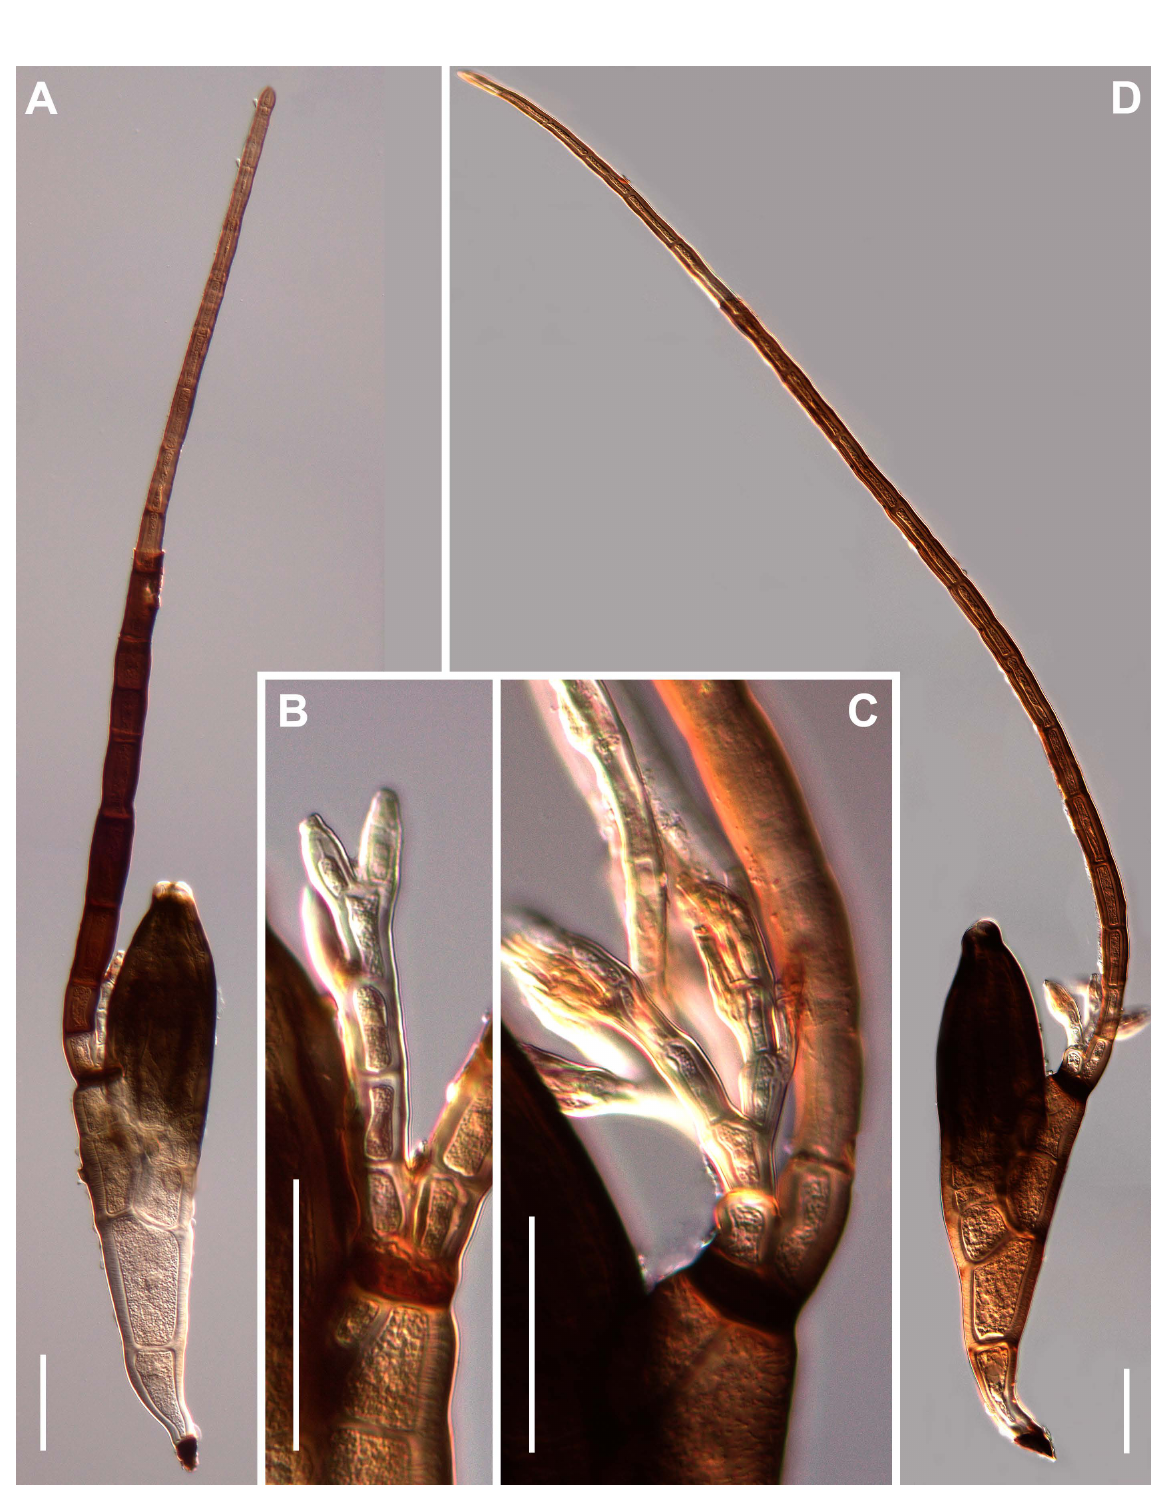
Fig. 25. Laboulbenia spp. A – B . L. argutoris Cépède & F.Picard. A . Mature thallus. B . Inner appendage in detail. – C – D . L. aubryi Balazuc. C . Inner appendage and area around insertion cell in detail. D . Mature thallus. Scale bars: 50 µm. Photographs from slides ZMUC C-F-122696 (A), ZMUC C-F-123050 (B), ZMUC C-F-122592